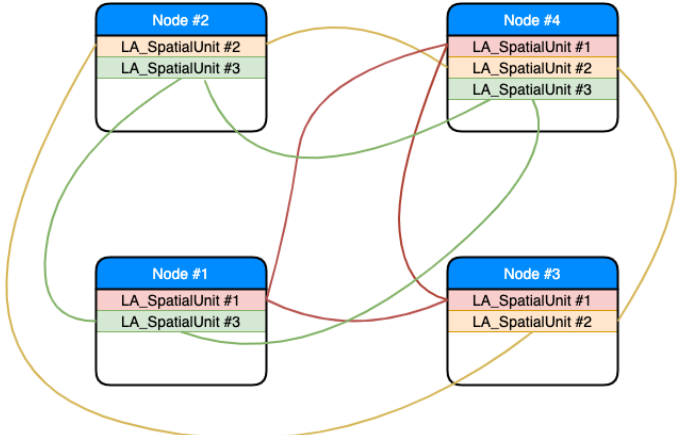
Figure 5. An example of combining replication and partitioning in a cluster with four